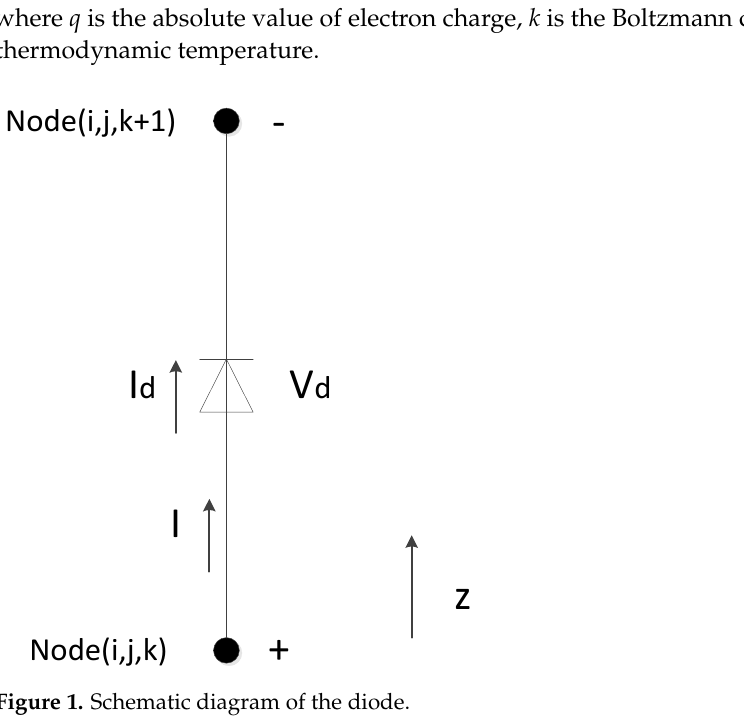
Figure 1. Schematic diagram of the diode.